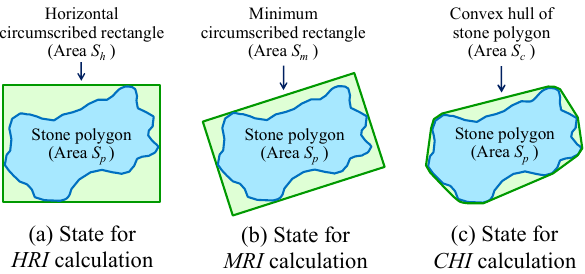
Figure 5. Relationship between stone polygon and circumscribed region for calculating irregular-shape indexes